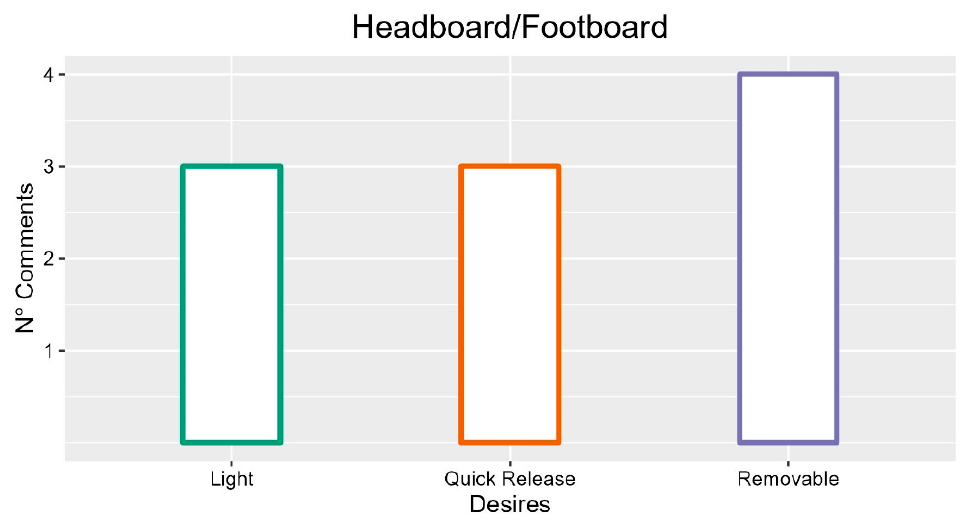
Figure 4. Graphical representation of desires with more occurrences for the Headboard/Footboard theme.